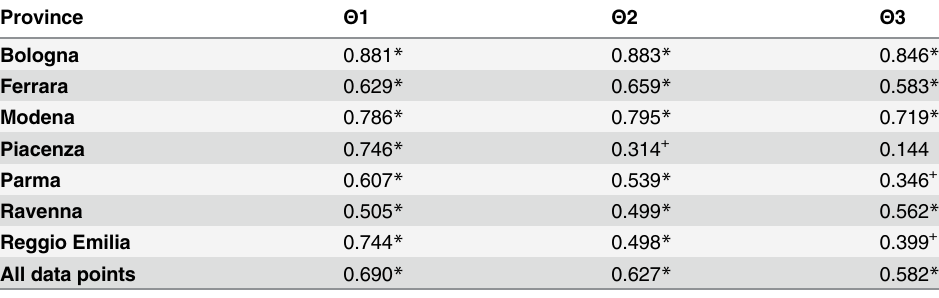
Table 1. Agreement between the observation and the simulations. Pearson correlation coefficients ( ρ ) are presented with p-values adjusted with Benjamini & Hochberg multiple test correction. Province Θ 1 Θ 2 Θ 3 0.881 *